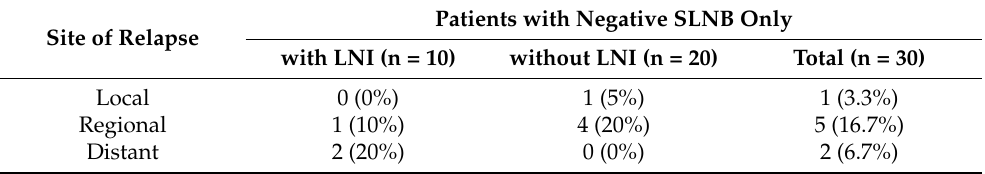
Table 3. Sites of relapse of the patients with negative SLN in absolute and relative frequencies, the tumor bed only (without LNI). One patient had local and regional failure simultaneously (in